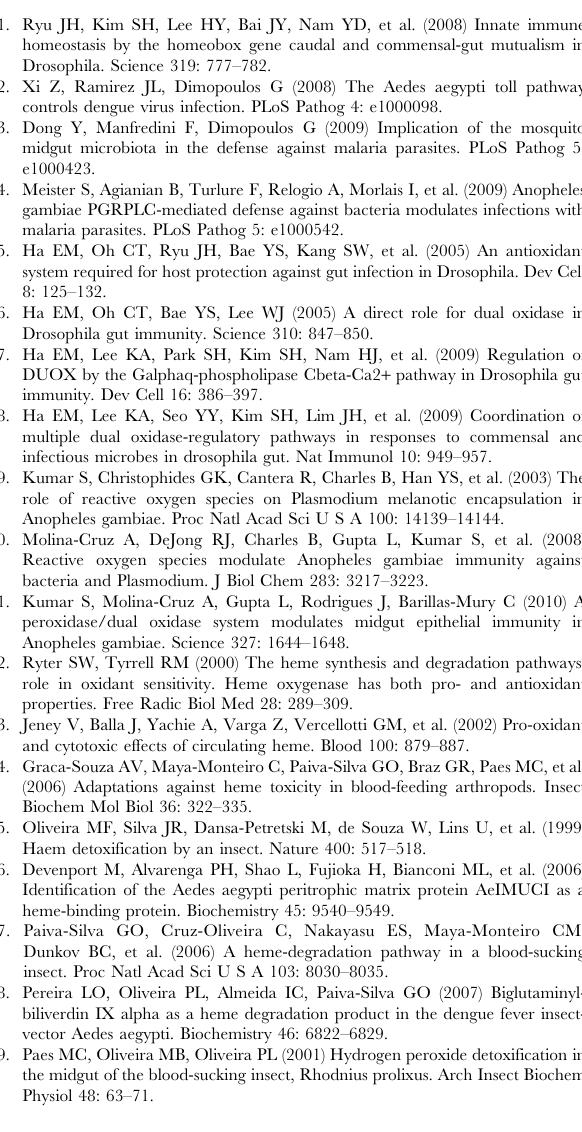
Figure S7 Mosquitoes were fed ad libitum with sucrose 5% supplemented 10 m M DPI for 5 days and RNA was extracted from the midgut and processed for 16S quantification through qPCR. Figure S8 Transmission electron microscopy from the bacterial population typically found in the gut of Aedes aegypti 24 hours after feeding mosquitoes with BBSA + Enterobacter asburiae + DPI (left) or BBSA + DPI (right). Found at: doi:10.1371/journal.ppat.1001320.s008 (0.67 MB TIF) Figure S9 Mosquitoes were fed with BBSA + DPI (10 m M) or BBSA + DPI + antibiotics (penicillin/streptomycin/tetracycline). 24 h later RNA from whole body (minus head) was extracted and gene expression was performed by qPCR. Dashed line indicates gene expression of mosquitoes fed with BBSA + bacteria (without DPI), similar to Figure 9E. Different classes of immune genes are indicated with colors. * P , 0.05, ** P , 0.01. *** P , 0.0001 after